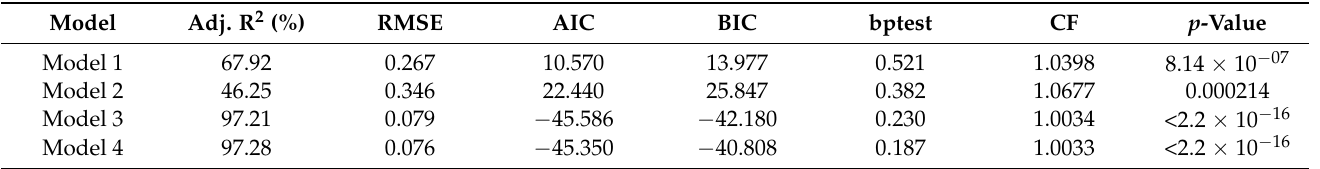
Table 6. Linear regression analysis result of stand structural variables and aboveground carbon stock